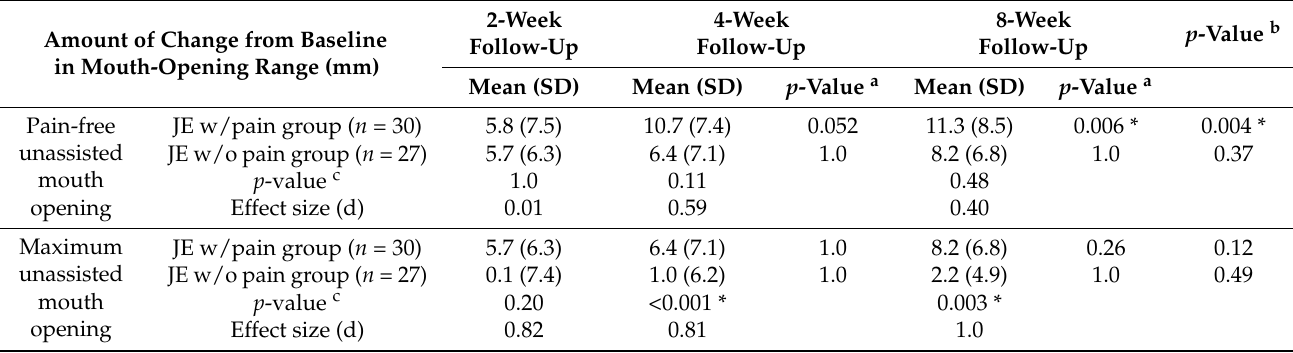
Table 3. Changes in mouth-opening range in the two